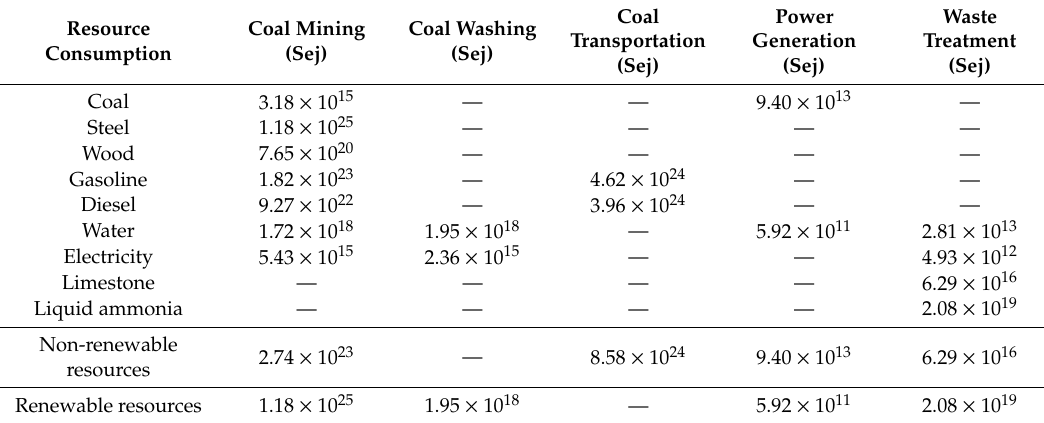
Table 8. Life cycle resource consumption of Unit